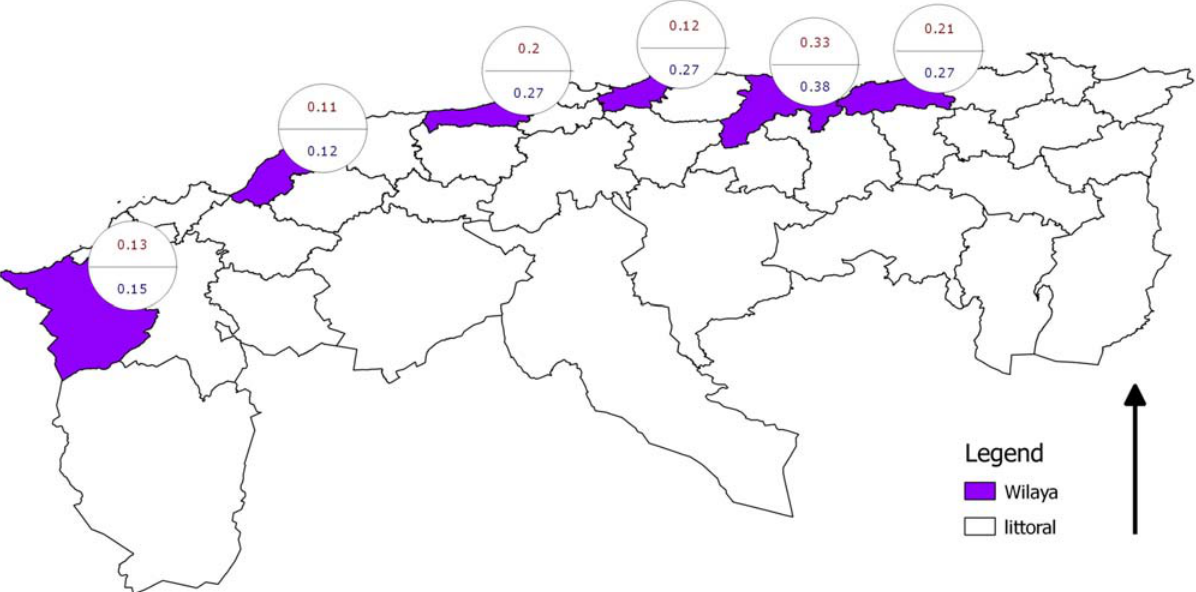
Fig 5. Canine Leishmania infection prevalence estimates according to full conditional test dependence model. Top prevalence is for first sampling period, bottom for